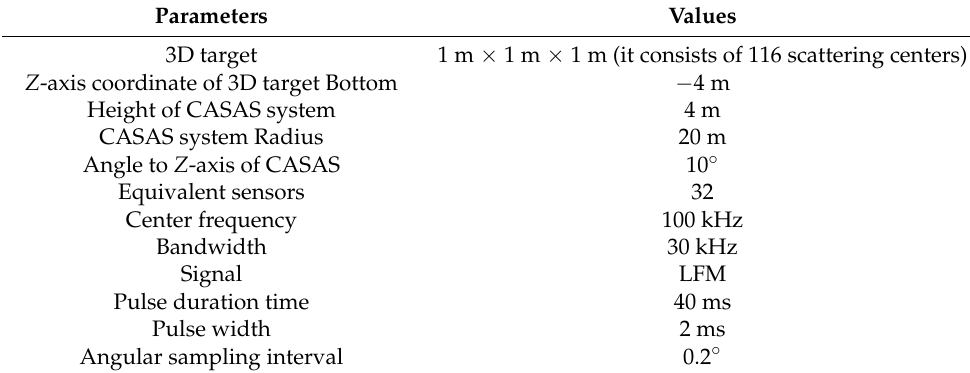
Table 2. CASAS system parameters for 3D imaging simulation. Parameters Values